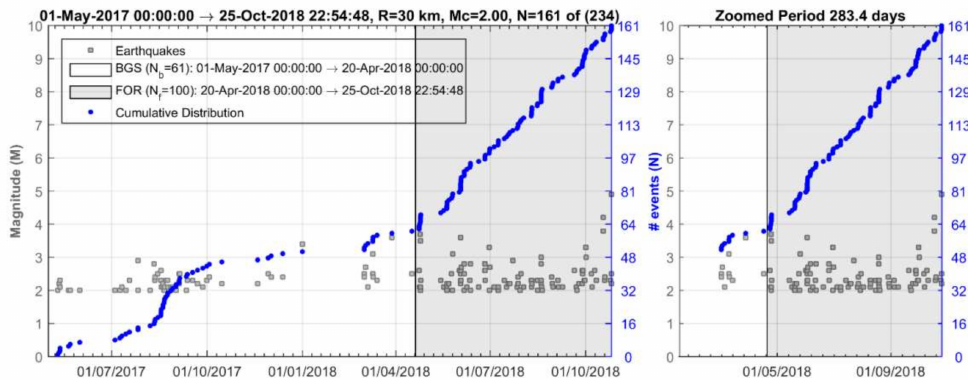
Figure 13. Time distribution of earthquakes (for Mc ≥ 2.0 number of events N = 161 out of 234 totally listed in the NOA catalogue) occurring during the 1 May 2017–20 April 2018 background seismicity period BGS 2 (number of events N b ) and the hypothetical foreshock activity (FOR-cluster 2, grey-shaded area, 20 April 2018–25 October 2018, number of events N f ). Plot in blue is the cumulative number of events versus time. Vertical bar shows a date of 20 April 2018. The same plot is zoomed from 1 February 2018 onwards. Seismicity testing showed that cluster 2 was a typical foreshock sequence (see Section 3.2.1). Two imminent foreshocks (M w = 4.1, M w = 4.8; see magnitude scale in gray area, also Figure 1b) were the largest ones during the entire foreshock sequence.